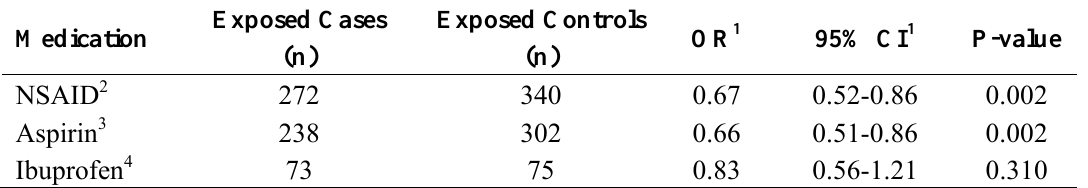
Table 3. Odds ratios and 95% confidence intervals for aggressive prostate cancer by use of NSAID medications.